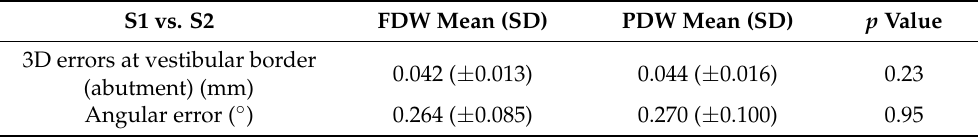
Table 3. Assessment of